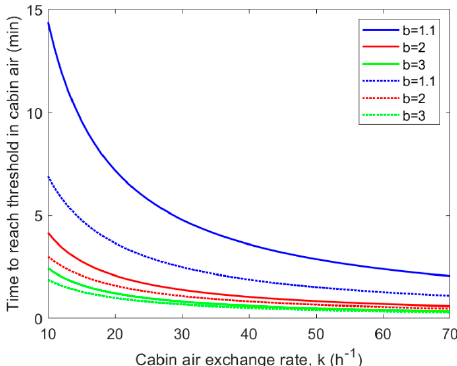
Figure 2. Time when the concentration of a substance in cabin air increases from the clean air level to the predefined threshold value. The time is displayed as a function of the air exchange rate between the cabin and its surroundings, for various concentrations of a substance in the mine air. The concentration in the mine air refers to the threshold level multiple, using b . Solid lines refer to substances emitted only outside the cabin, such as NO, NO 2 , and CO. Dotted lines refer to CO 2 .